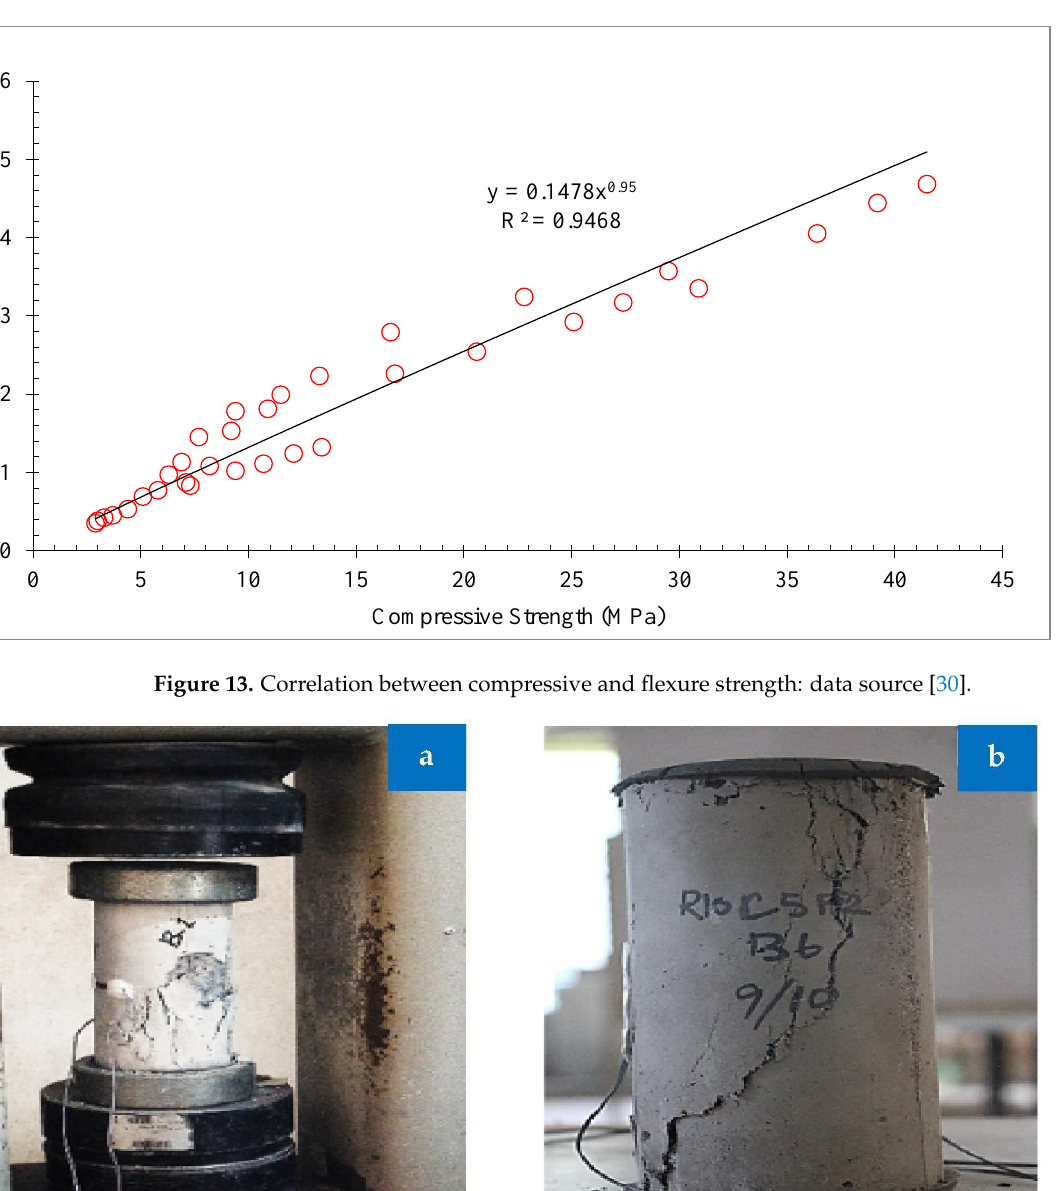
Figure 15. Splitting cylinder failure: ( a ) reference and ( b ) combination of RCA, rubber, and fibers [44]: used as per Elsevier permissions. The failure pattern of the concrete beam during an FS test is seen in Figure 16. In the control and just recycled concrete aggregate (RCA) replacement specimens, the load-de- flection curve quickly plummeted and split into two halves. When the maximum stress was applied, the beams with fiber, especially the combinations with 2% fiber, did not com-